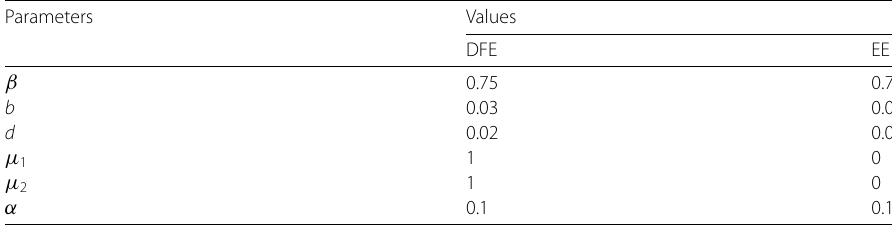
Table 1 Parameters used for Numerical study Parameters